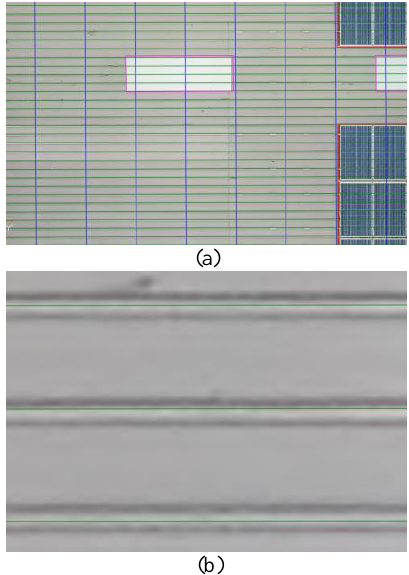
Figure 9: Mapped corrugations (green lines); (a) larger roof